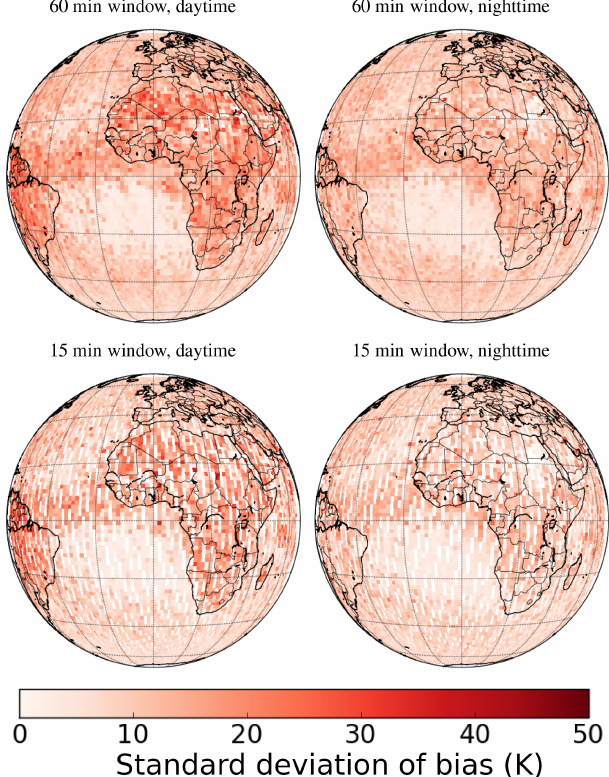
Figure A2. Spatial distribution of the standard deviation of the bi- ases in SEVIRI cloud top temperature retrievals during 2007. Data are shown for both the daytime (13:30LST CALIOP overpass) and night-time (01:30LST CALIOP overpass), using a 60min colloca- tion window and a 15min collocation